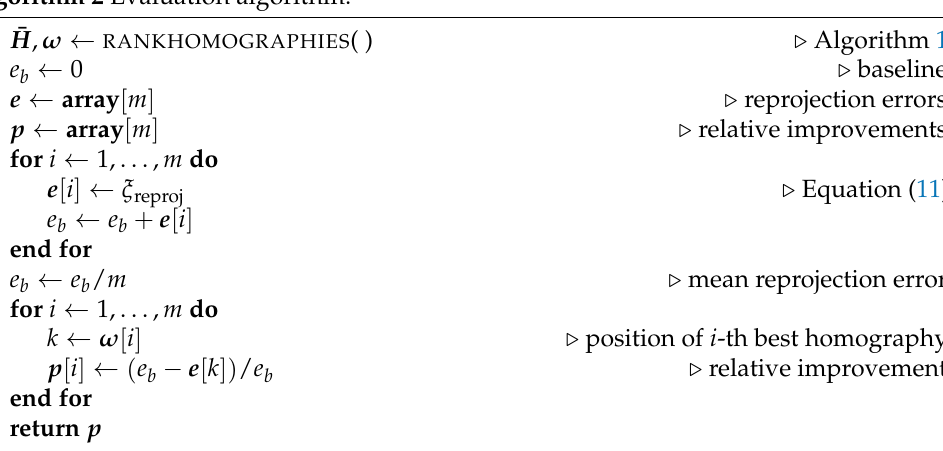
Algorithm 2 Evaluation algorithm.